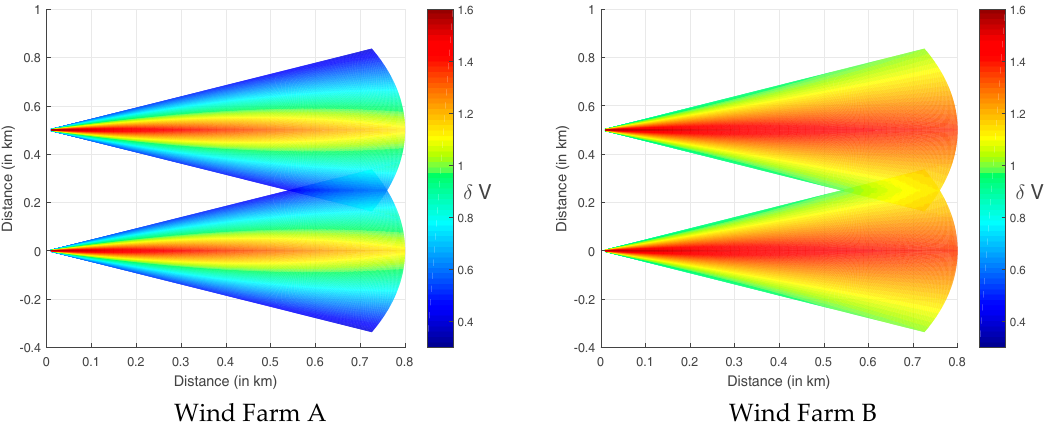
Figure 5. Simulation of velocity deficits δ V with two lateral turbines for an undisturbed wind speed of 7 m/s coming from the left, wind farm A ( left ) and wind farm B ( right ).